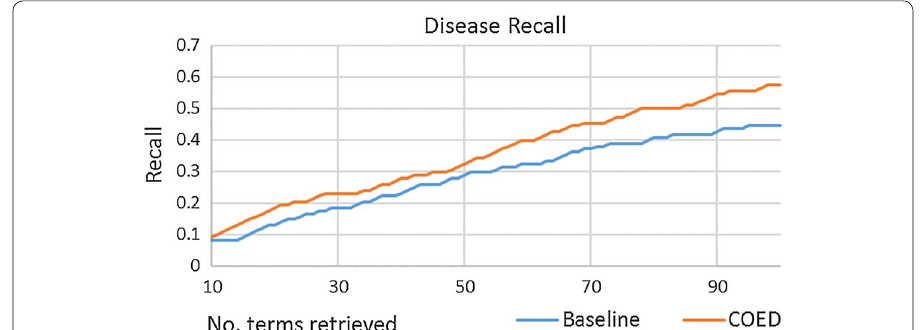
Fig. 5 Comparison of disease recall for baseline and COED methodologies